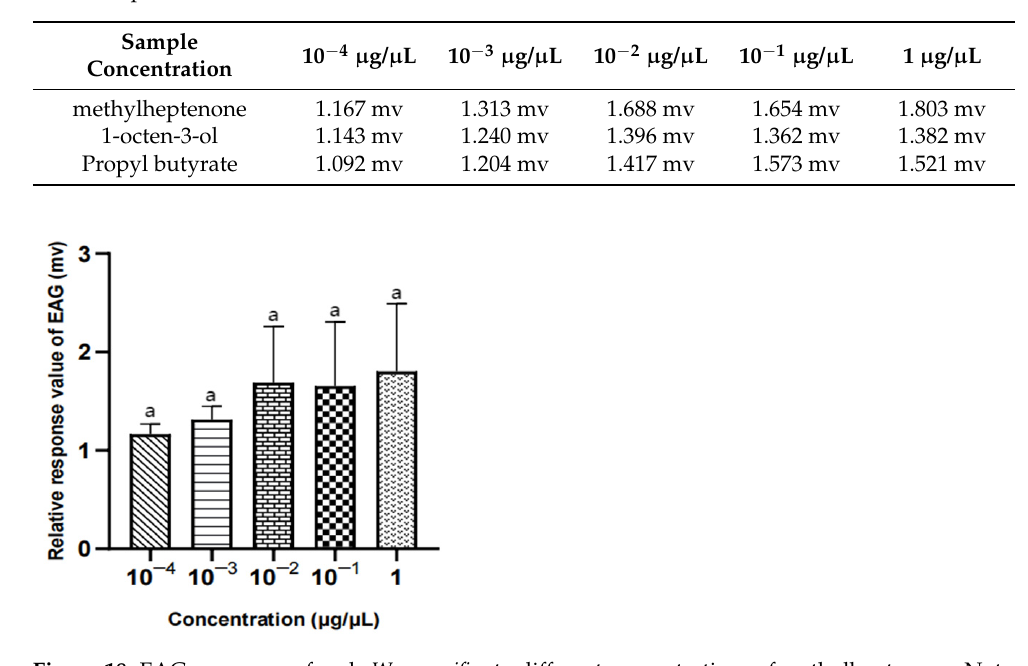
Figure 18. EAG responses of male W. magnifica to different concentrations of methylheptenone. Note: The same letter indicates no difference ( p > 0.05), but different letters indicate significant difference ( p < 0.05), so a and b are both indicate no difference, ab indicates significant difference. Different column shapes represent different concentrations of samples. The same below.